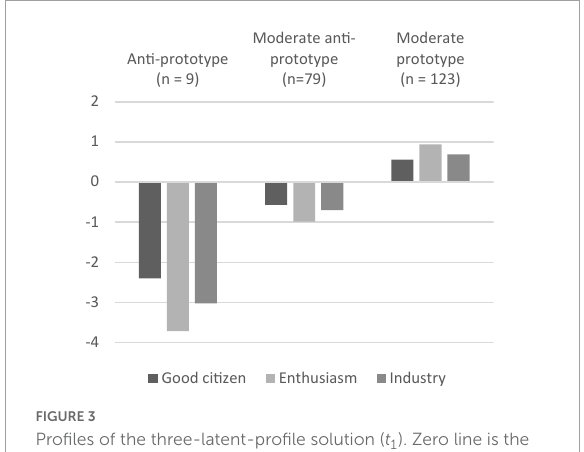
FIGURE3 Profiles of the three-latent-profile solution ( t 1 ). Zero line is the grand